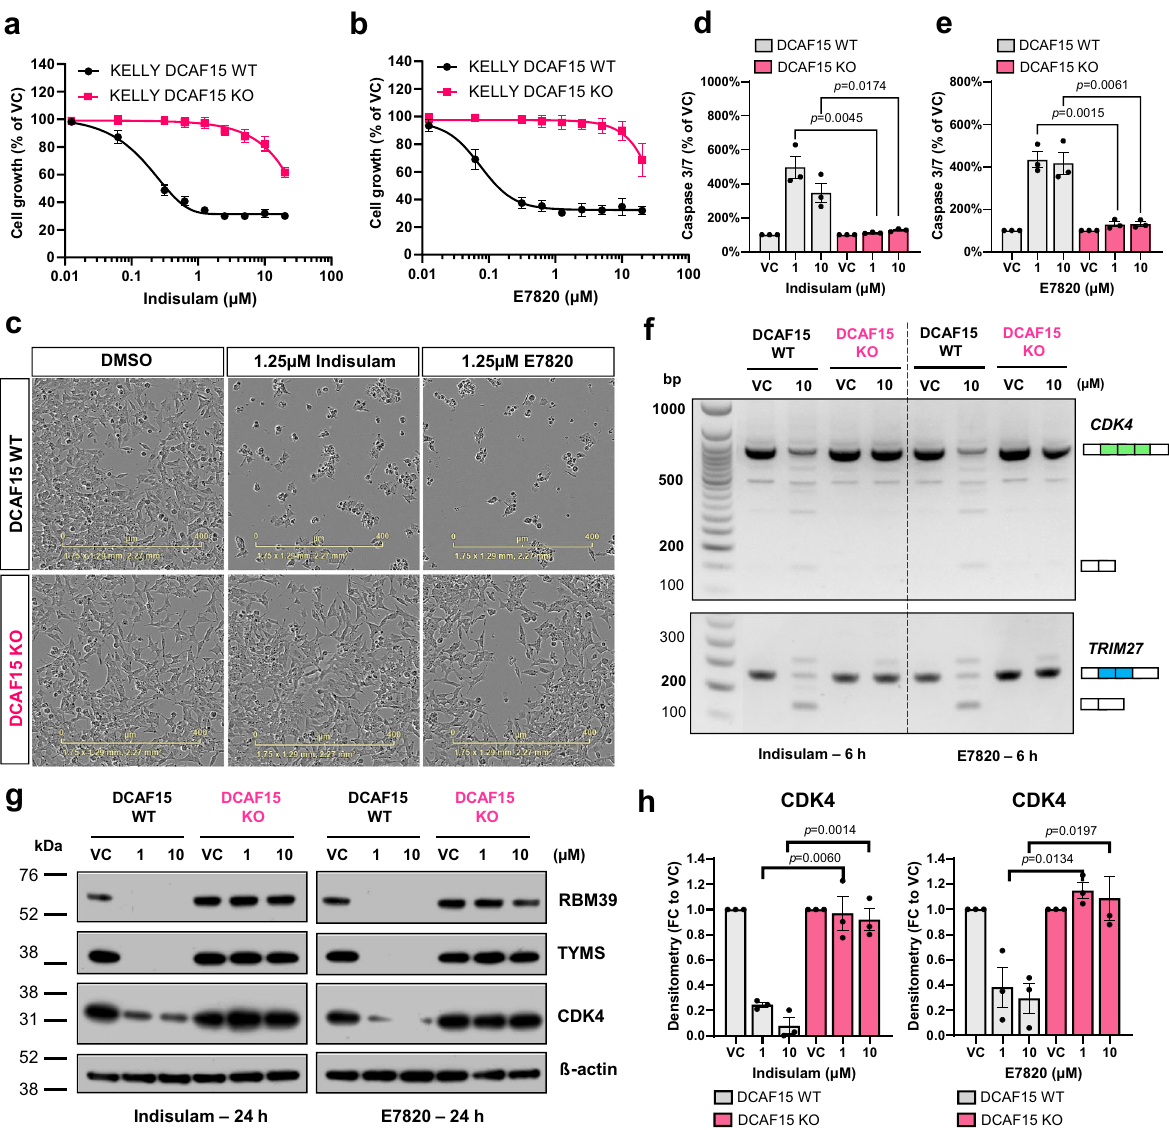
Fig. 4 RBM39 degradation and RNA mis-splicing via aryl sulfonamides is DCAF15 dependent. a , b KELLY DCAF15 WT or DCAF15 KO cell line treated with aryl sulfonamide indisulam ( a ) or E7820 ( b ) for 72 h. Cell growth was measured by SRB assay. n = 3 independent experiments. c Representative images of KELLY DCAF15 WT or DCAF15 KO cells treated with 1.25 μ M indisulam or E7820 (IncuCyte, Sartorius) ( n = 3 independent experiments). The scale bar